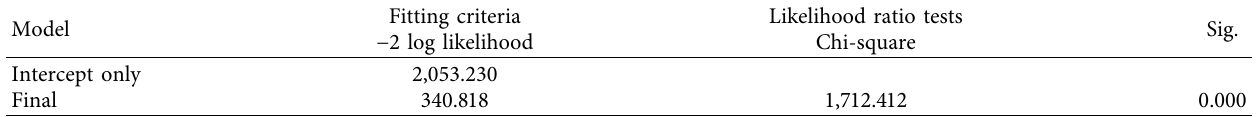
Table 10: Model fitting information.